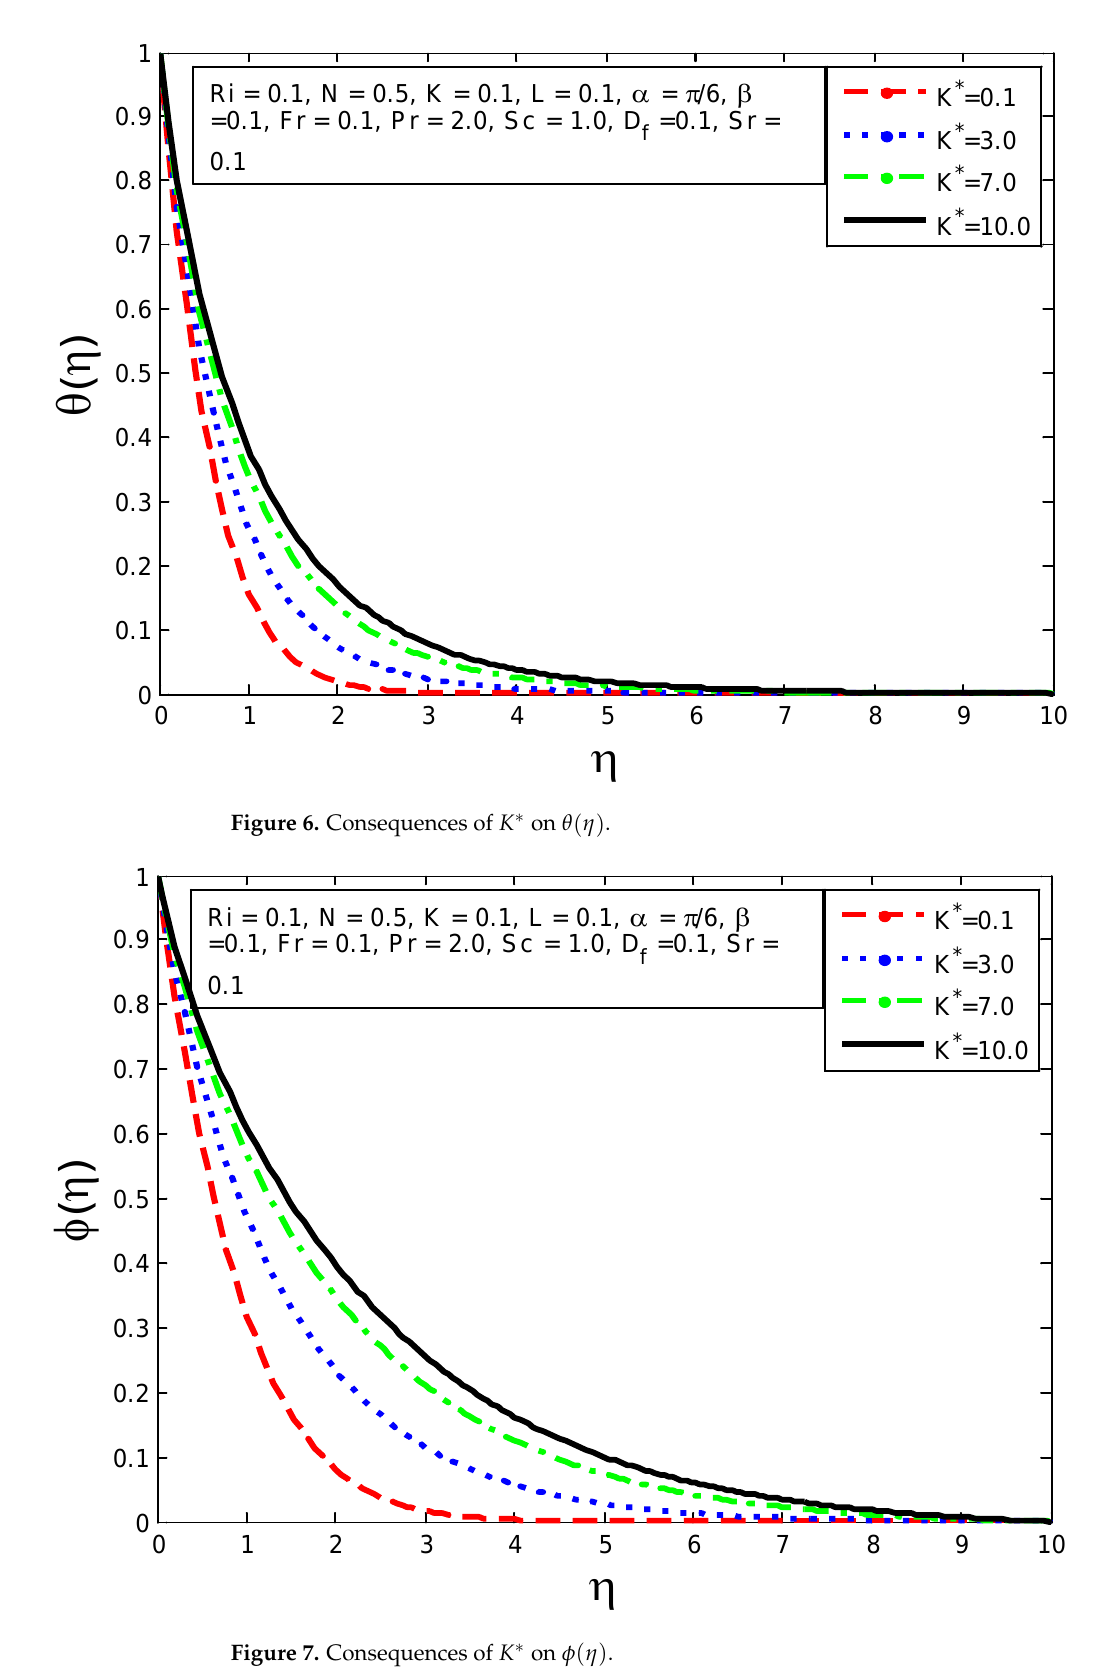
Figure 5. Consequences of on